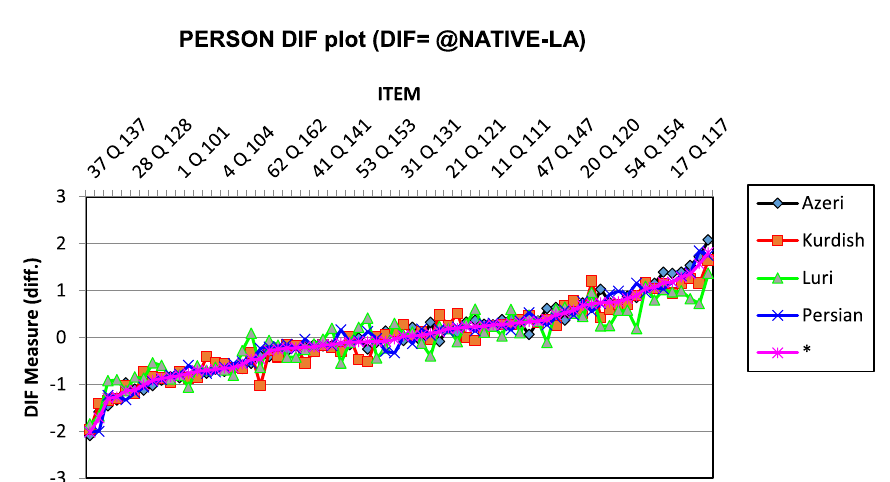
Fig. 3 Uniform differential item functioning in the Iranian Undergraduate University Entrance Special English IUUESEE